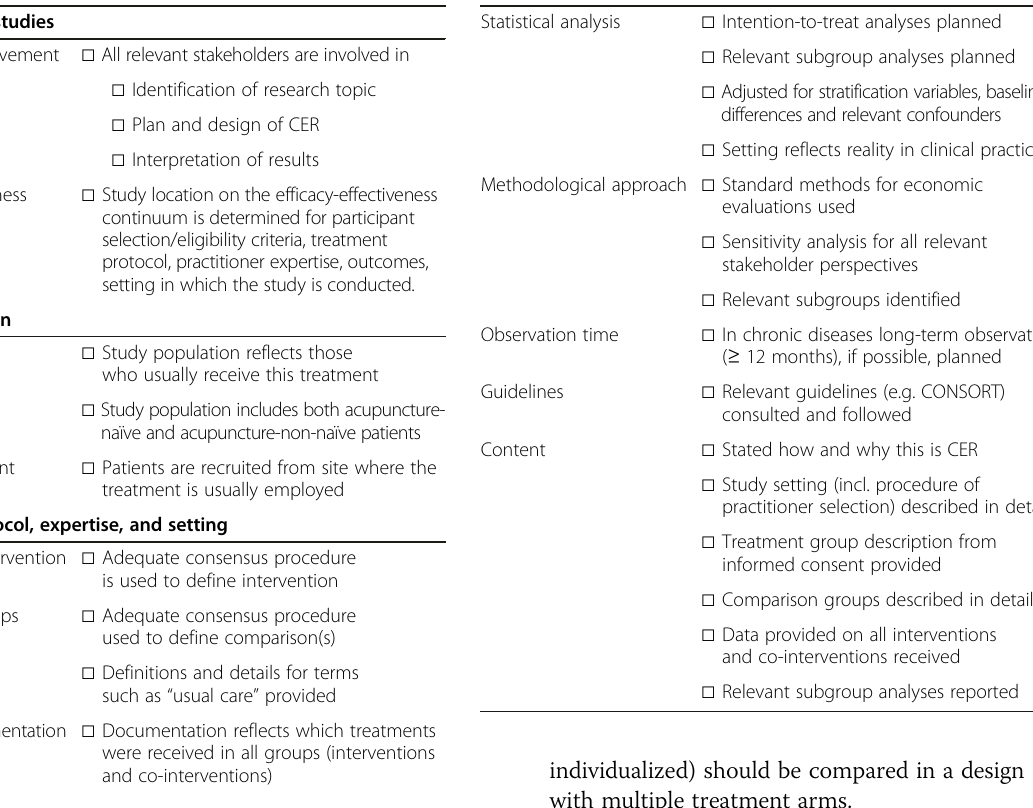
Table 1 Checklist for CER relevant aspects